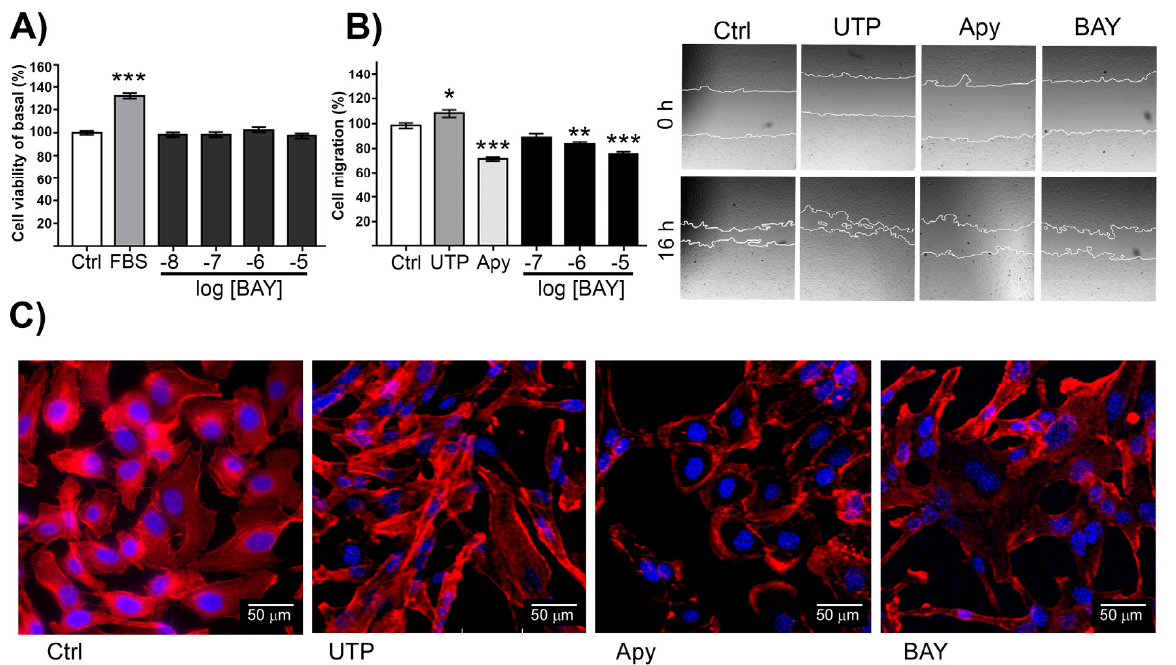
Figure 3. Stimulation of A2BR inhibits basal SKOV-3 cell migration but has no effect on cell viability. ( A ) Cultures of SKOV-3 cells at 50% confluence were stimulated for 24 h with BAY-606583 from 10 nM to 10 µ M; then, cell viability was estimated by MTS assay. ( B ) Confluent cultures of SKOV-3 cells were stimulated for 16 h with BAY-606583 from 100 nM to 10 µ M, and cell migration was estimated by scratch assay. UTP (100 µ M) and Apy were used as positive and negative controls, respectively. ( C ) SKOV-3 cells were treated for 16 h with 100 µ M UTP, 10 U/mL Apy or 10 µ M BAY-606583; then, the actin cytoskeleton was stained with rhodamine-coupled phalloidin, and nuclei were counterstained with DAPI. In the graphs, bars represent the mean ± S.E.M. of four independent experiments in sextuplicate for A and in triplicate for B. * p < 0.05, ** p < 0.01, *** p <